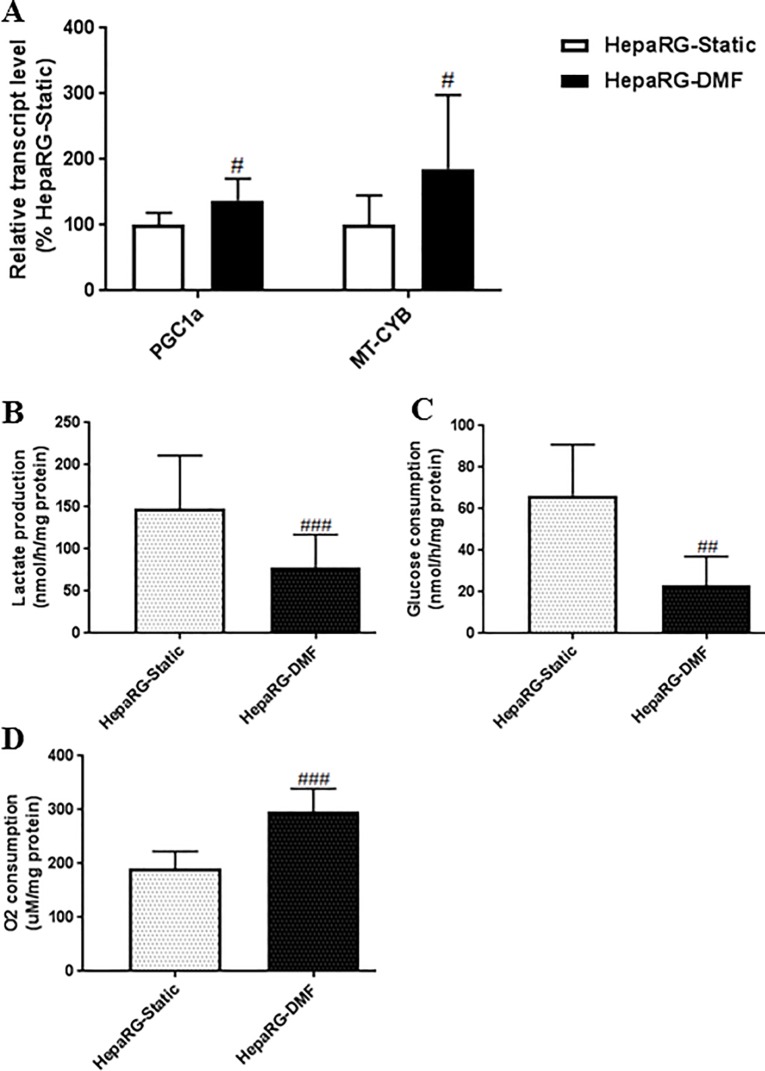
DMF increases mitochondrial energy metabolism of HepaRG cells.(A) Transcript levels of PGC1a and MT-CYB, n = 6/group. (B-D) Lactate production, glucose and oxygen consumption, n = 9-15/group. Significance Static vs DMF: # = P value <0.05, ## = P value <0.01, ### = P value <0.001 and #### = P value <0.0001.